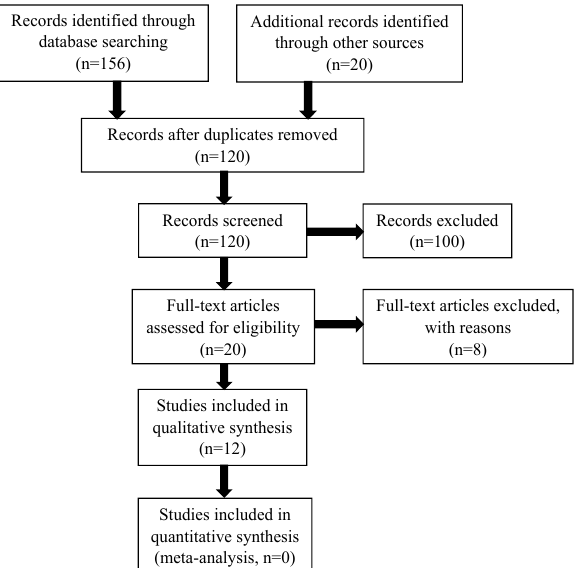
Fig 1: Flow diagram of selected studies for systematic review